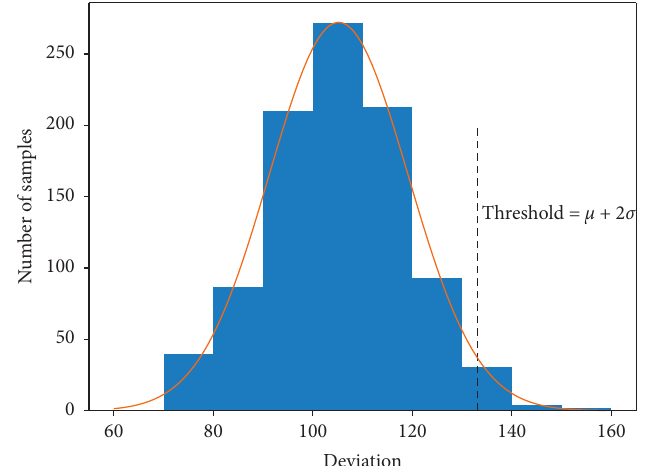
Figure 3: The distribution of samples’ deviation.